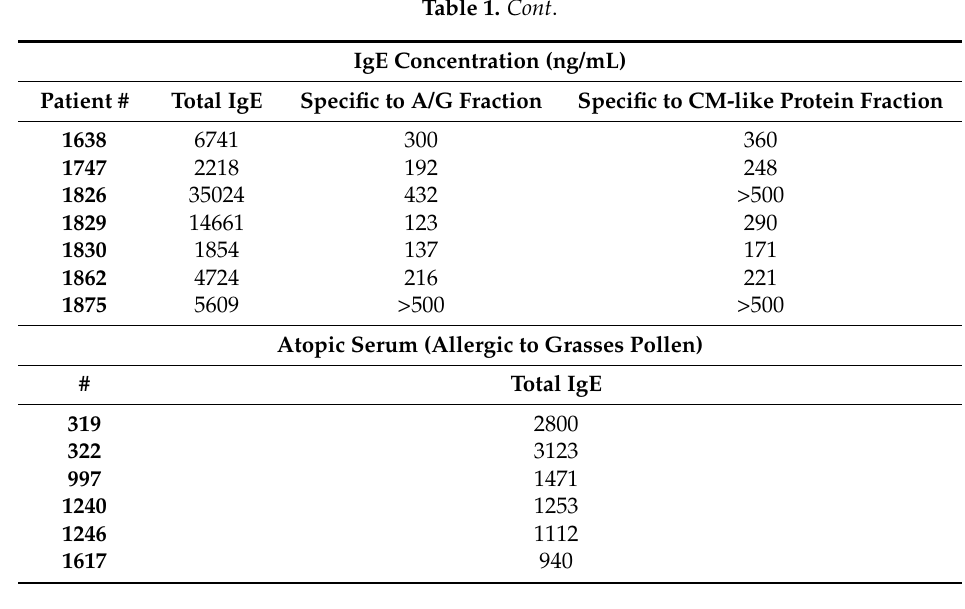
Table S1 List of primers used for cloning CM3, CM16 and 0.28 genes, Table S2. Serum identification and clinical characteristics of patients allergic to